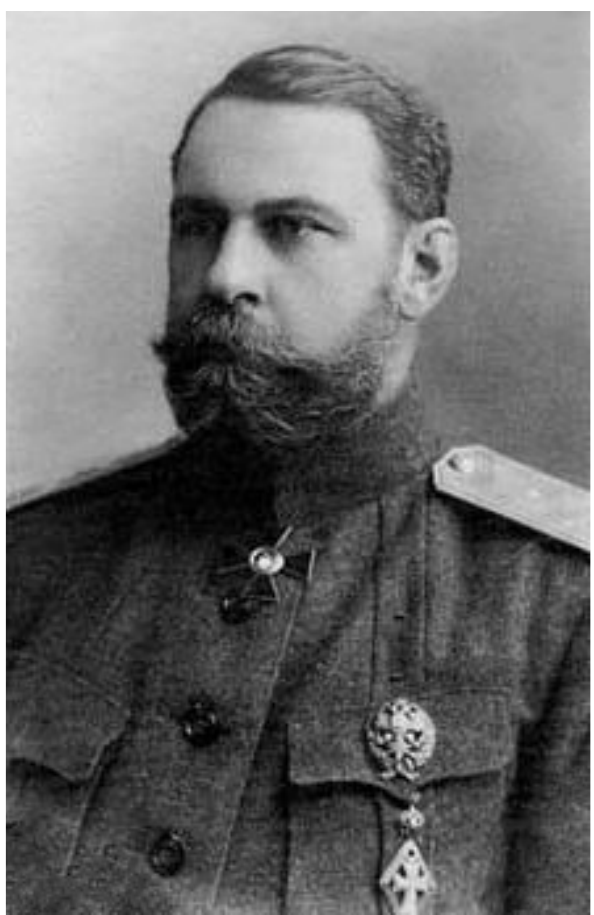
Figure 1. Vladimir Nikolayevich Ipatieff (1867-1952) (Public domain, from reference 20] . The image was made in 1914. V. N. Ipa- tieff is in the uniform of Lieutenant General